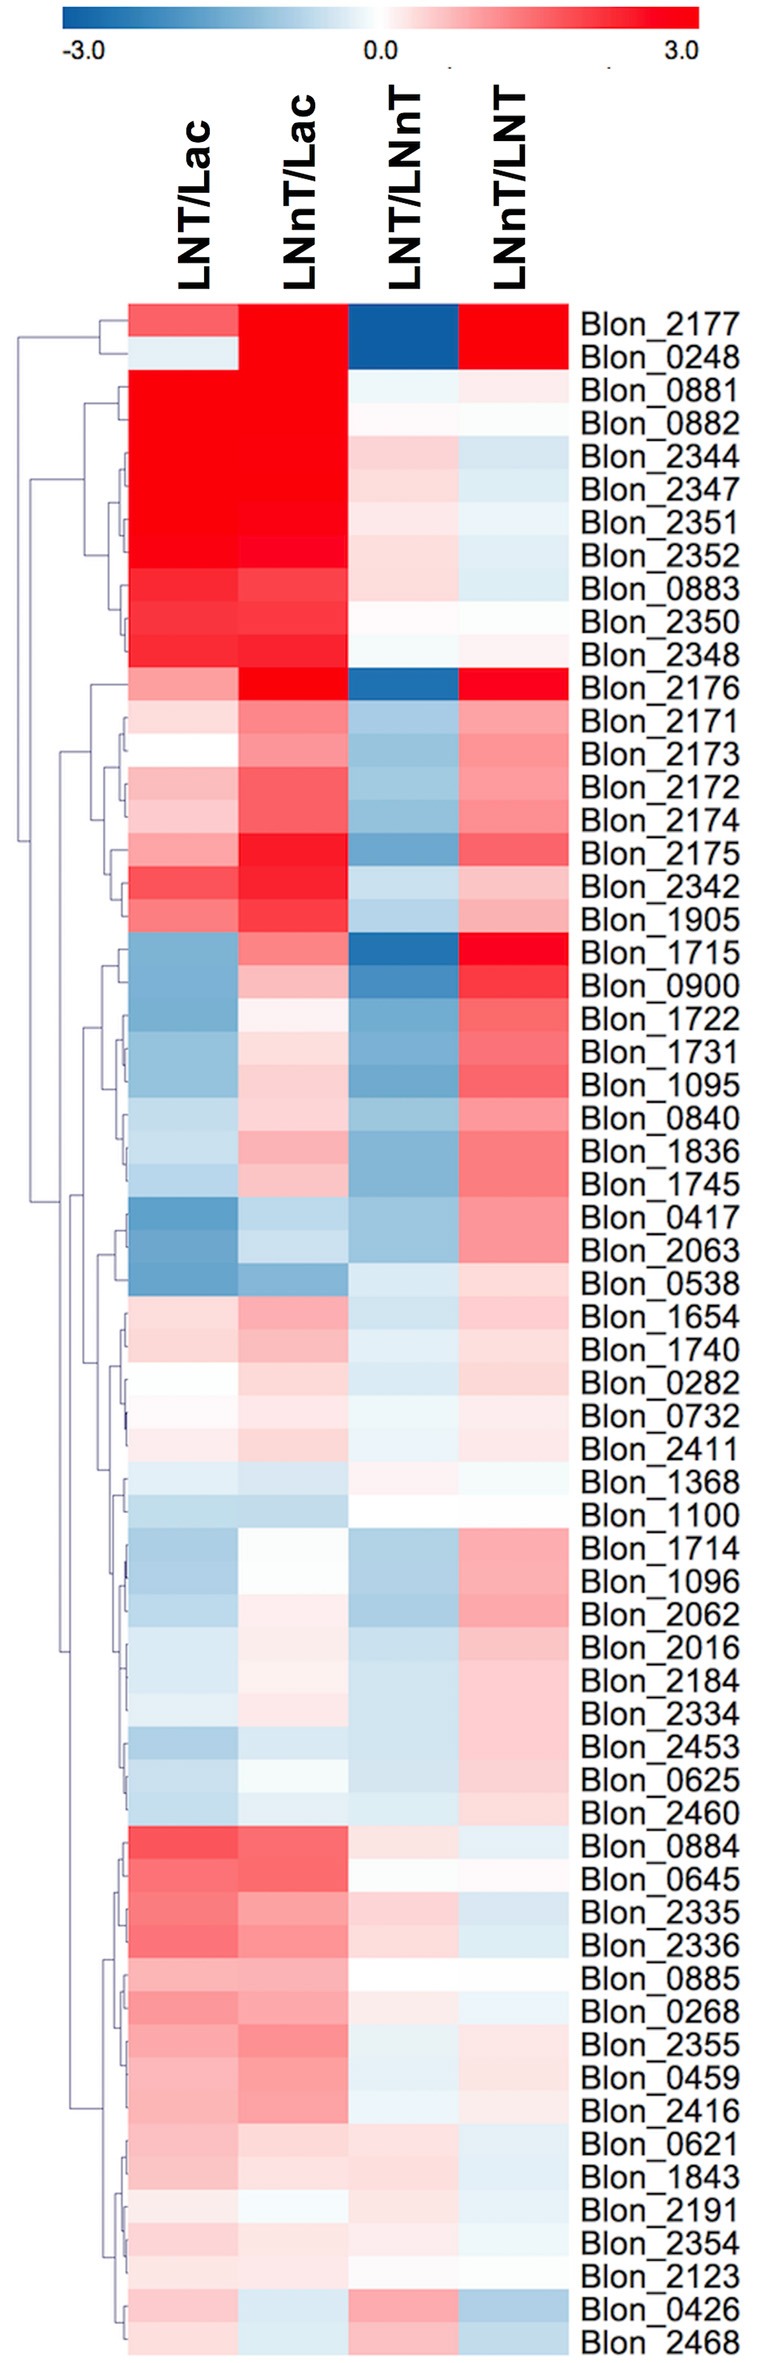
Relative gene expression within the global transcriptome depicted as log2-fold change. The log2-fold change gene expression from independent biological duplicates was performed from raw reads using the R package DESeq2. The 2-fold change expressions were subjected to hierarchical clustering using Euclidean distance and depicted as z-scores. Gene annotations and predicted functions are reported in Table S2.